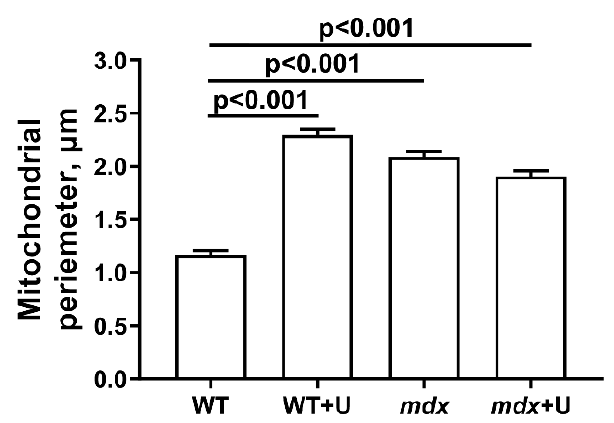
Figure 5. Perimeter of the mitochondria ( µ m) of the skeletal muscles of experimental animals. The number of examined fields of view was 50–70 in each group. The data are presented as means ± SEM.